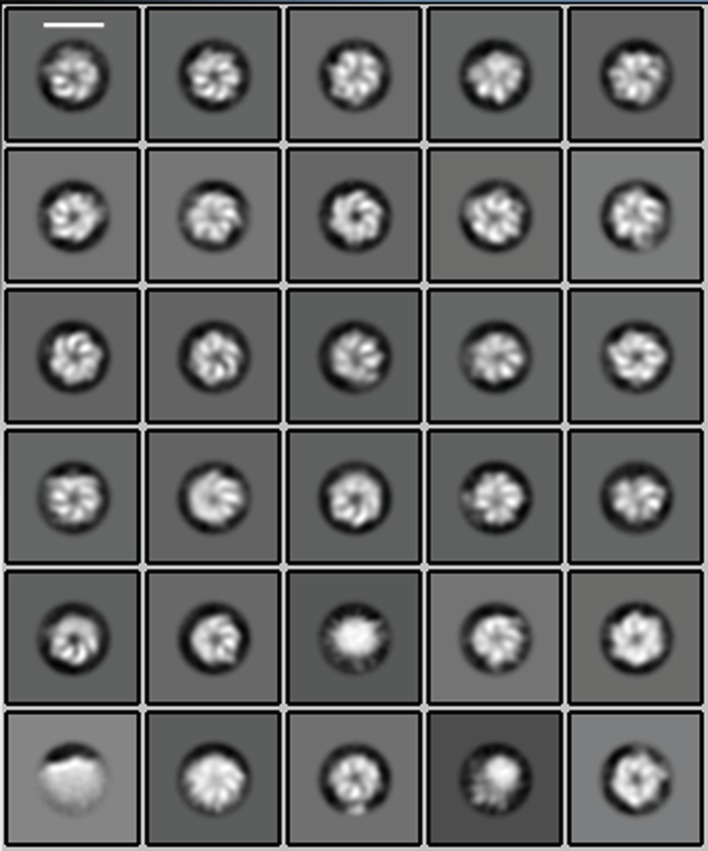
Electron microscopy image averaging.2D class averages of Cpa particles show predominantly ring-shaped particles. Scale bar represents 150 Å.